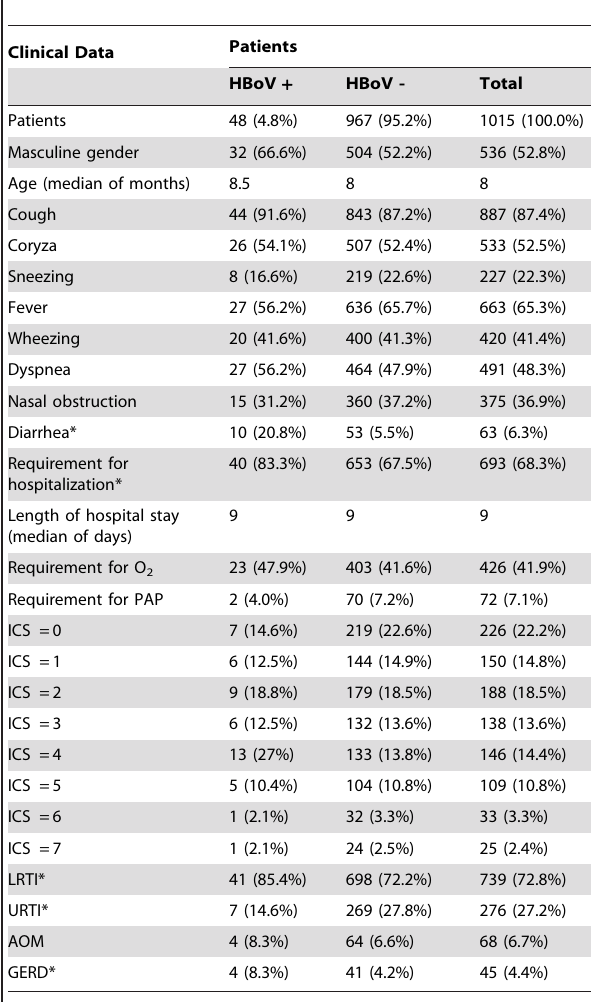
Table 1 . Clinical and demographic data of patients with and without